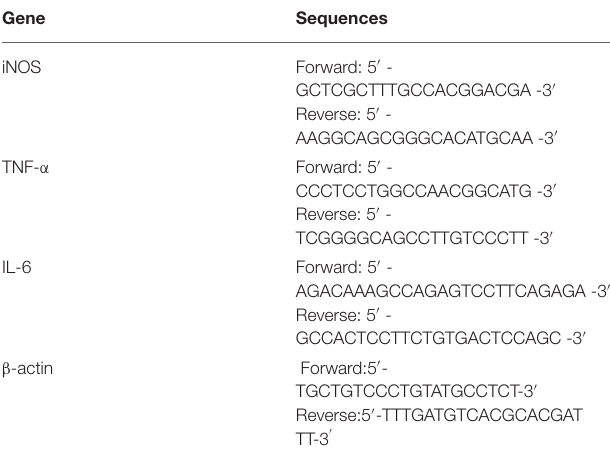
were measured by NanoDrop2000 spectrophotometer